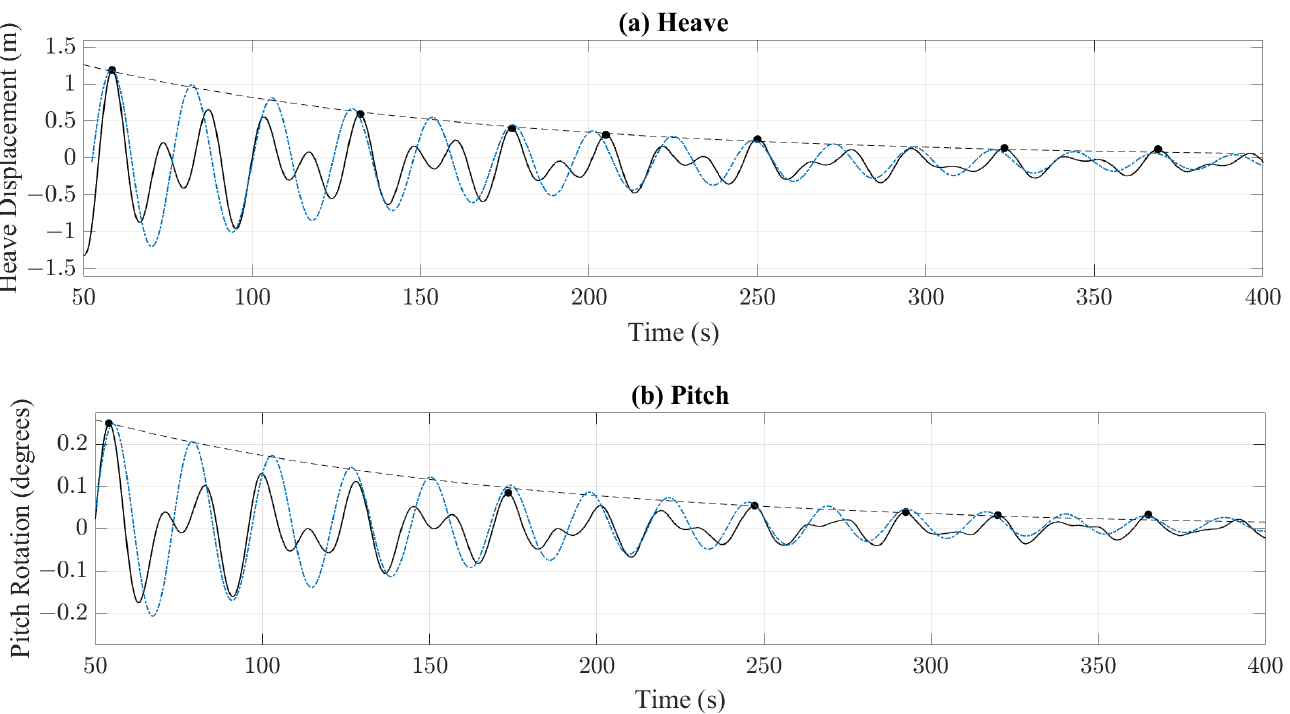
Figure 4. Interrogation of experimental free decay tests: ( a ) heave component during heave-free decay test and ( b ) pitch component during pitch-free decay test.